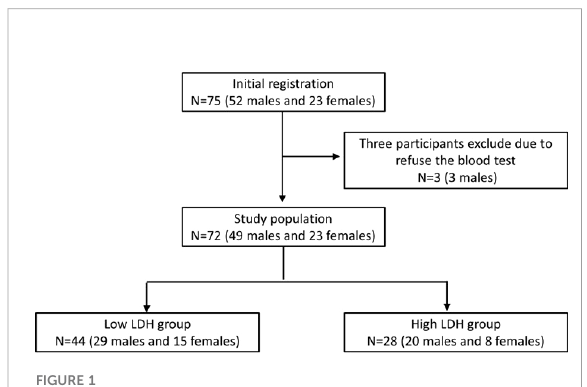
FIGURE 1 Flowchart showing the inclusion of the study